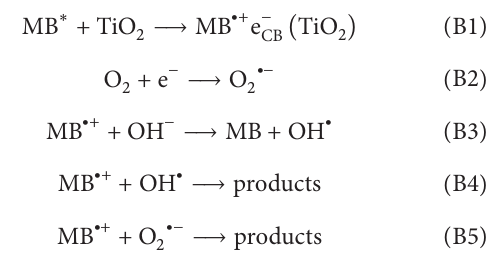
The hydroxyl radical existing on the surface of diatomite accelerated the degradation of MB ( B 3)